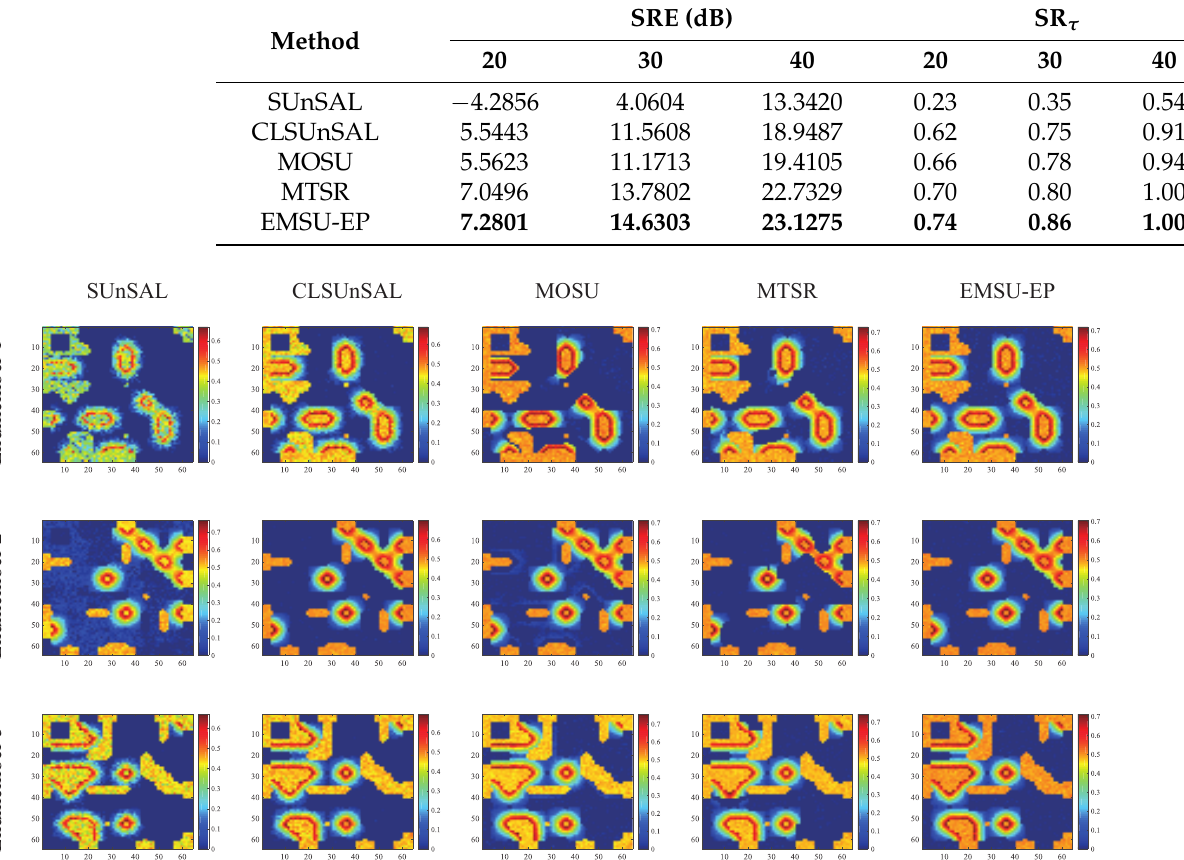
Figure 8. The estimated abundance maps of endmember 1, endmember 2 and endmember 5 for data 1 on 30 dB SNR obtained by different algorithms.